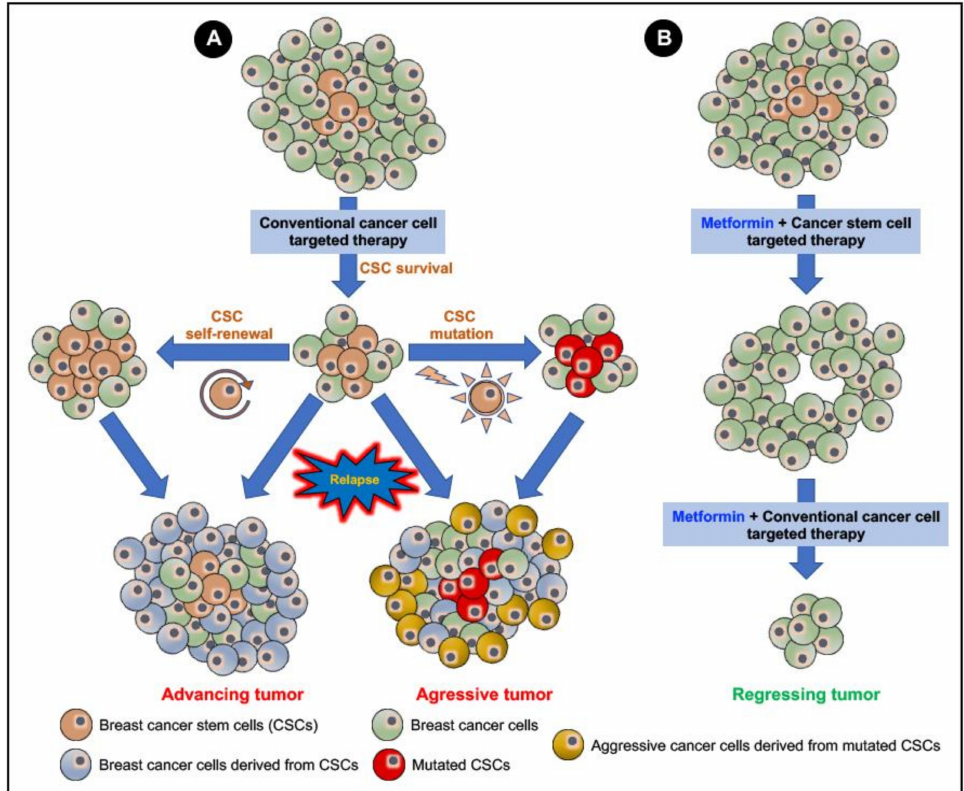
Figure 5. E ffi cacy of a combinatory metformin and breast cancer stem cell (BCSC) targeted therapy over conventional cancer cell-targeted therapy: A conventional anti-cancer therapy targeting terminally di ff erentiated cancer cells ( A ) should e ffi ciently inhibit cell proliferation and induce the apoptotic cell death of the cancer cells. However, the less abundant CSCs e ff ectively evade therapeutic intervention. Then, the CSC through a process of self-renewal and generation of tumor progenitor cells and mutations mainly causes a relapse / recurrence of more aggressive, invasive, and metastatic forms of the neoplasm. Using metformin in combination with a cancer stem cell-targeted therapy ( B ) will e ff ectively target and kill the CSCs, which then can be followed up with a combinatory treatment using metformin and the conventional anti-cancer therapy to cause tumor regression, e ff ectively cure cancer, and avoid cancer relapse /